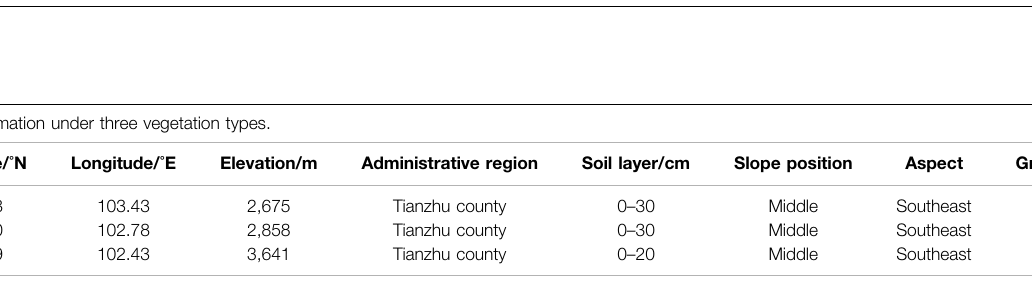
FIGURE 1 | Study area (red circle) and sampling sites (orange hollow dots). The landscapes of the fi eld sampling sites of the alpine desert steppe (ADS), alpine steppe (AS), and alpine meadow (AM).